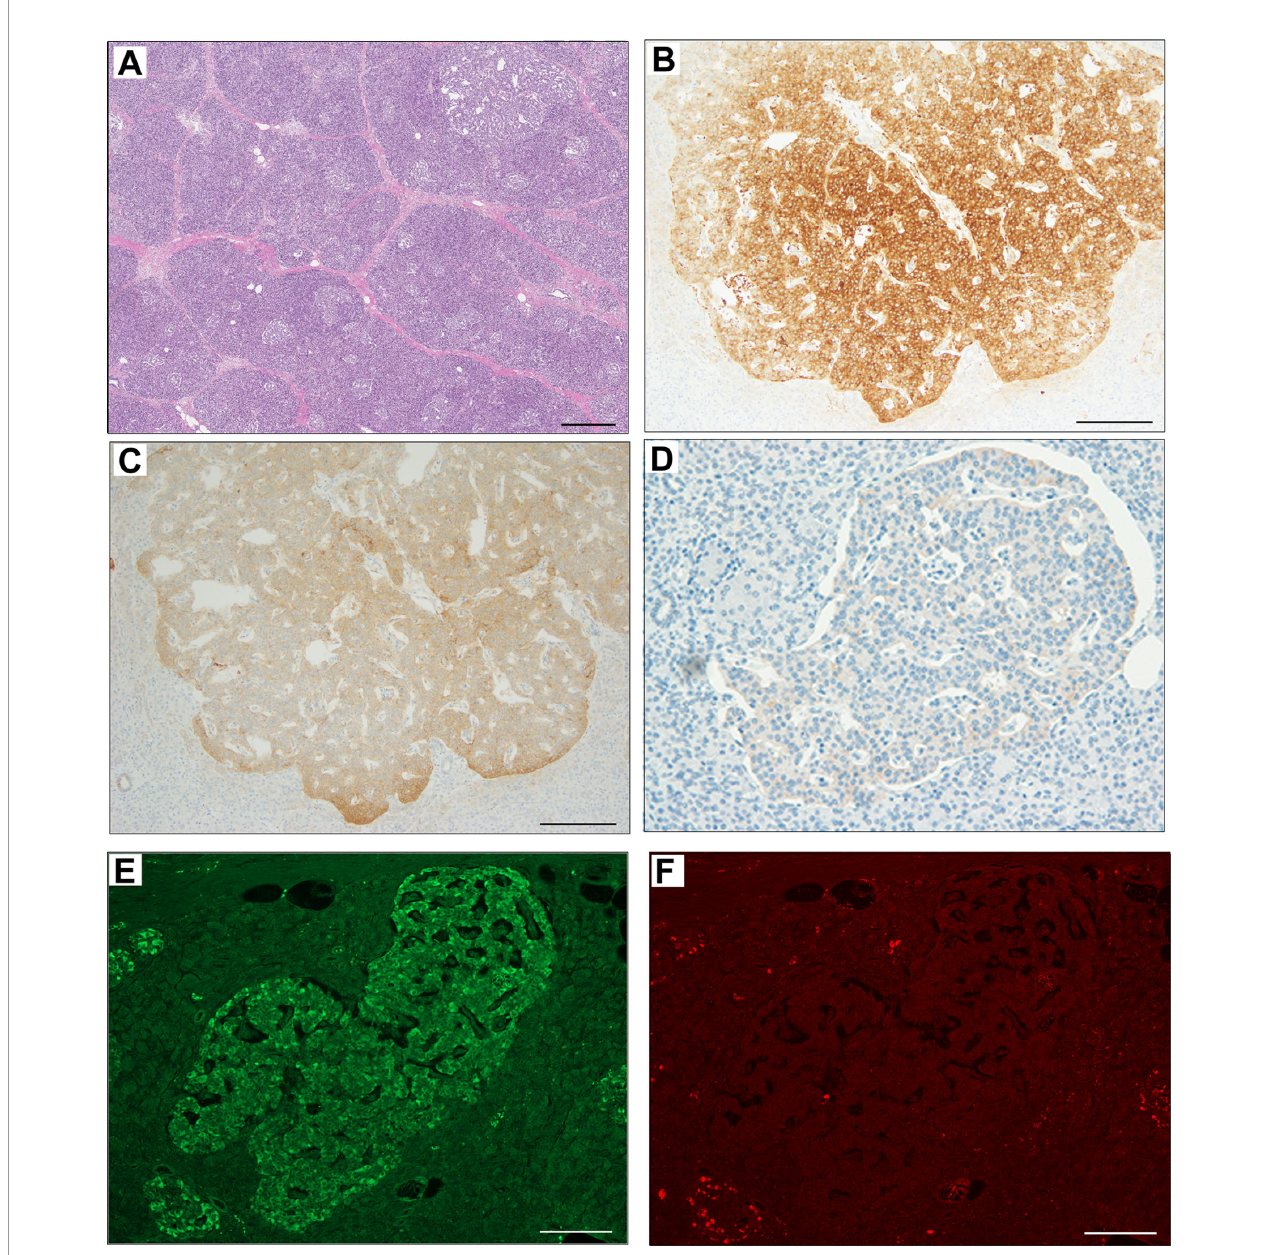
FIGURE 3 | Immunohistochemical staining of pancreas surgical specimen. Low magni fi cation of pancreatic tail tissue stained with hematoxylin & eosin (A) . Immunohistochemical staining of pancreatic tail tissue showed positivity for synaptophysin (B) , neural cell adhesion molecule or CD56 (C) , somatostatin receptor 2 (D) , and insulin (E) . Glucagon staining was negative (F) . Scale bar indicates 500 µm in (A) and 200 µm in (B – F)